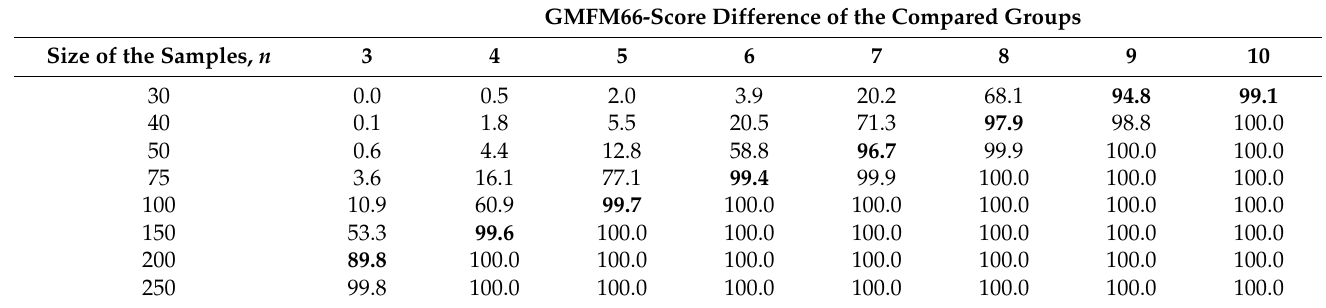
Table 3. Power of GMFM-66 and MDSC to detect differences in GMFM-66 score in samples of different group sizes with defined GMFM-66 score